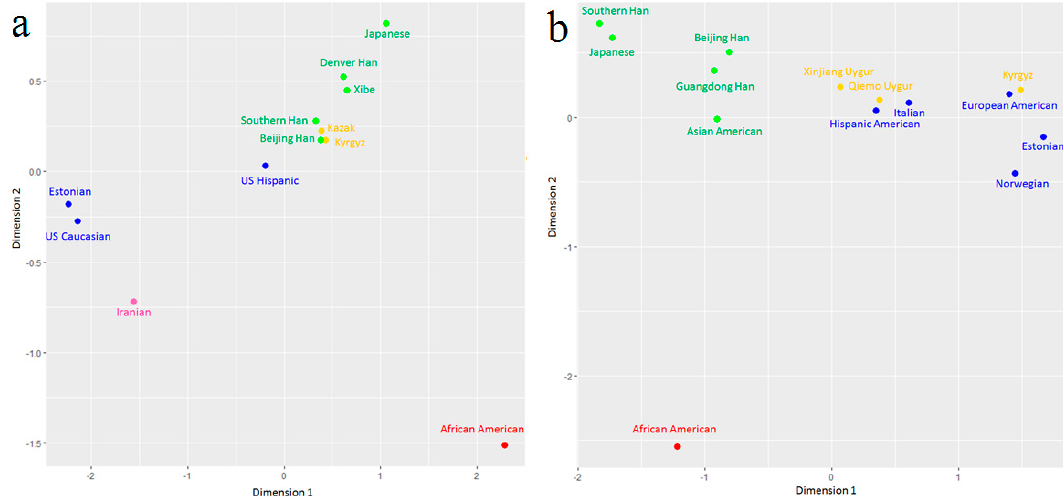
Figure 3. The multidimensional scaling analysis (MDS) plots for Kyrgyz group and reference populations, ( a ) based on the same of 58 mtDNA SNPs; ( b ) based on the same of 23 Y-STRs.